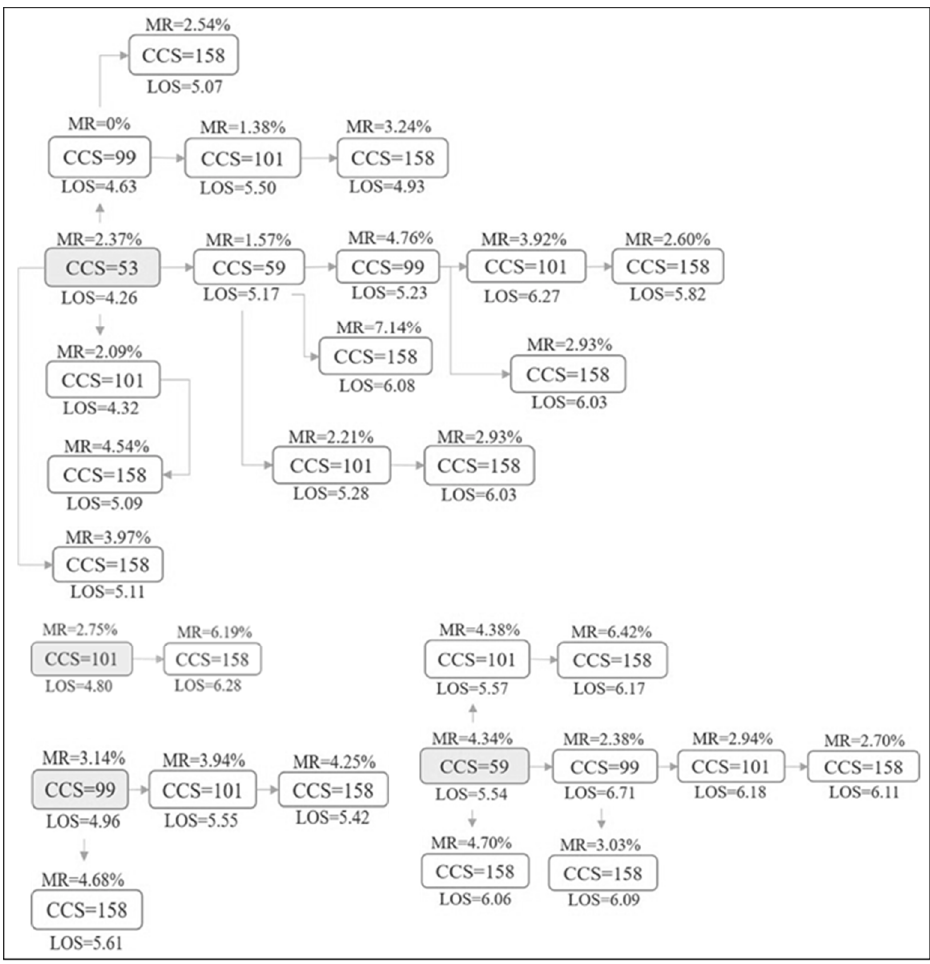
Figure 2. E ff ects of comorbidity constructs on LOS and mortality rate. Figure 2. Effects of comorbidity constructs on LOS and mortality rate.